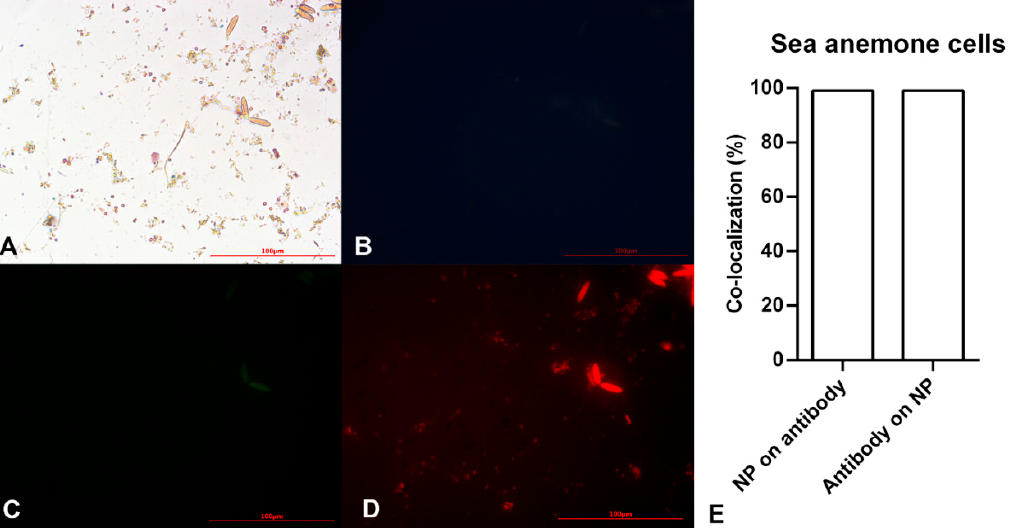
Figure 4. Microscopy images of sea anemone stem cells after exposing to Alexa Flour anti-Oct4 antibody-conjugated iron nanoparticles using ( A ) brightfield, ( B ) blue filter, ( C ) green filter, and ( D ) red filter. ( E ) Co-localization of conjugated iron nanoparticle staining and anti-Oct4 antibody in sea anemone stem cells. Columns show Manders’ coefficients expressed as percent values.